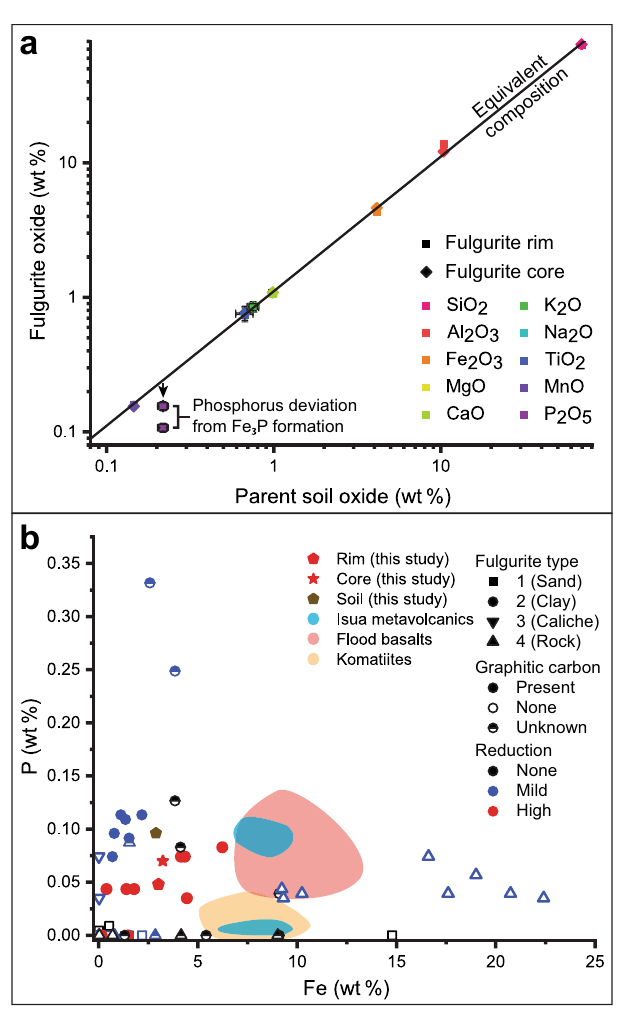
Fig. 3 Fulgurite chemistry. a Chemistry of the parent soil vs. fulgurite core and rim in this study. The equivalent composition line is the parent soil normalised to an anhydrous and organic-free composition. Error bars represent per cent uncertainty de fi ned by measurements of standard STSD4 (see ‘ Methods ’ and Supplementary Table 1); where not shown, uncertainties are smaller than the used symbol. b Iron vs. phosphorus